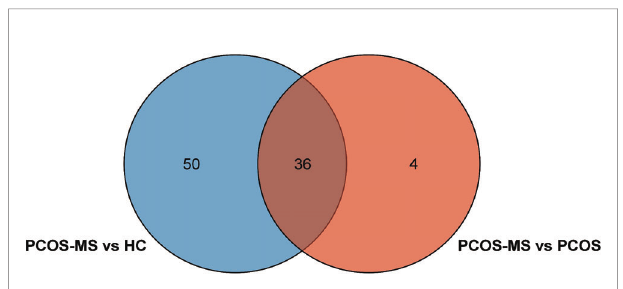
FIGURE 3 | Venn diagram of differential metabolites in groups of HC, PCOS,